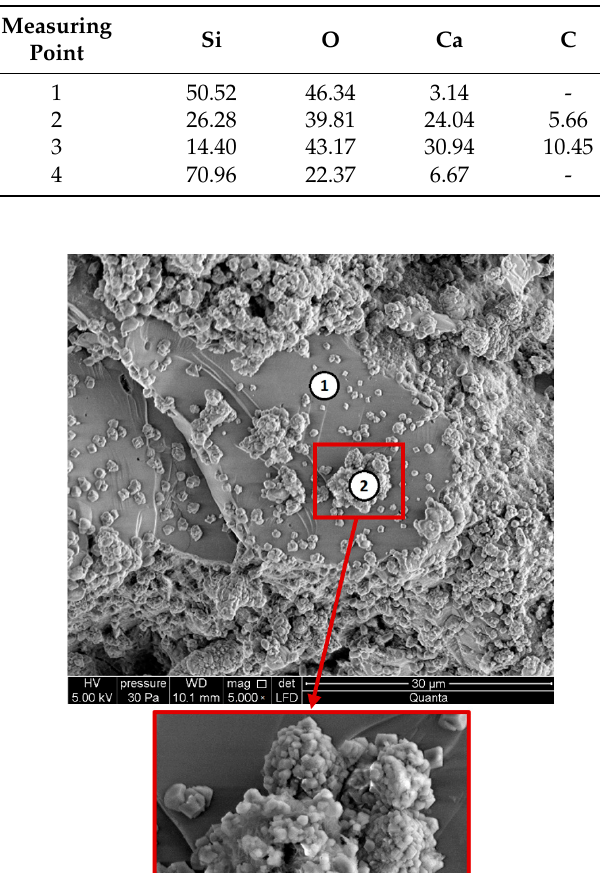
Table 3. Mass share of elements detected in EDS analysis of the reclaimed cement concrete (RCC) at measuring points 1–4.